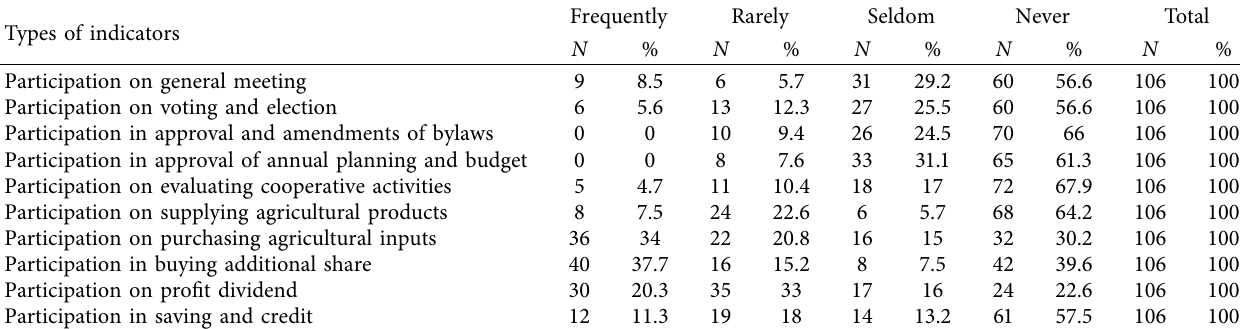
Table 5: Frequency of membership participation in activities of multipurpose